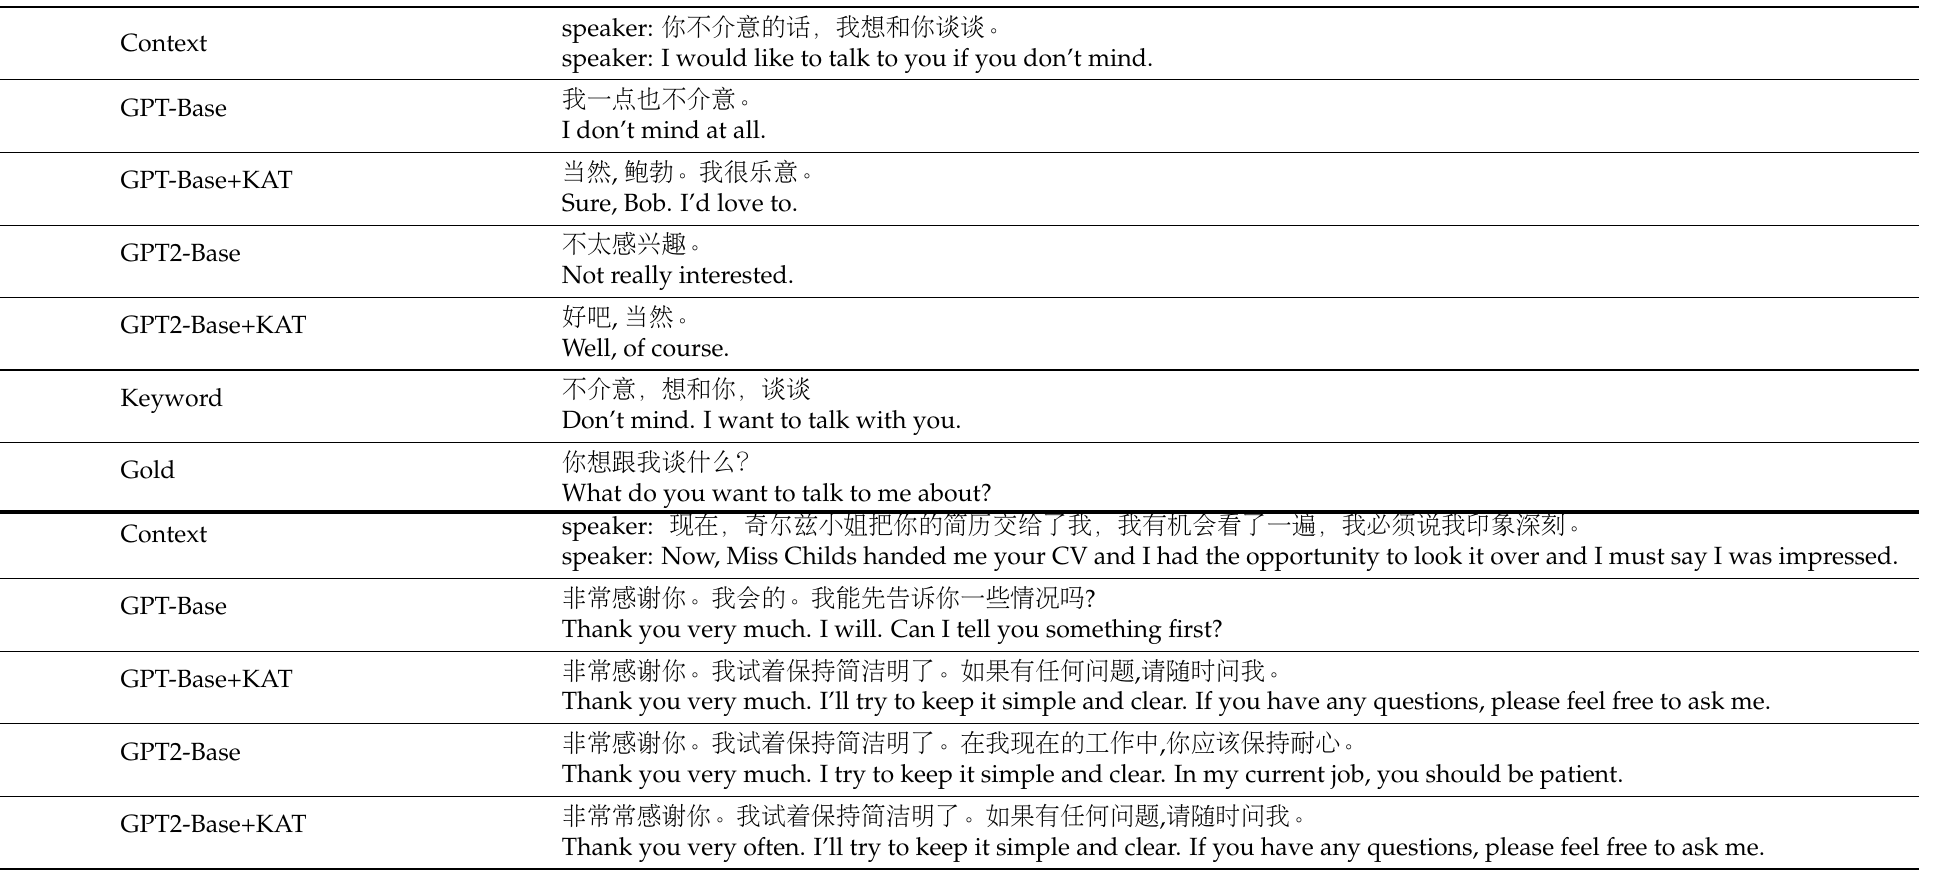
Table 7. Generated sentences by our proposed